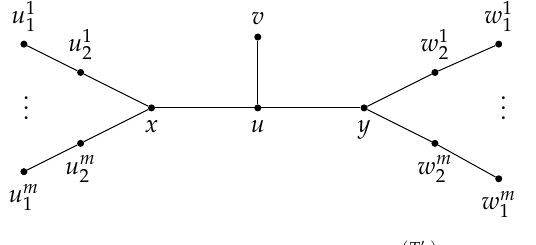
( T (cid:48) ) = γ pr ( T m pr